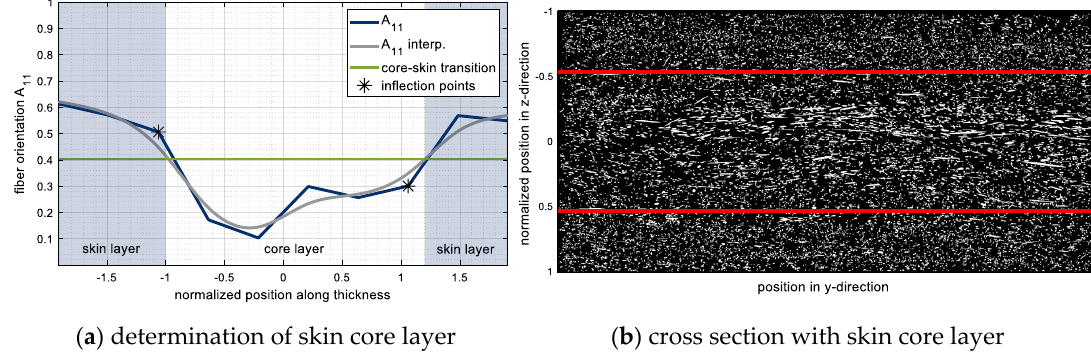
Figure 19. Method to determine the skin core layer ratio of a reinforced material by objective criteria.